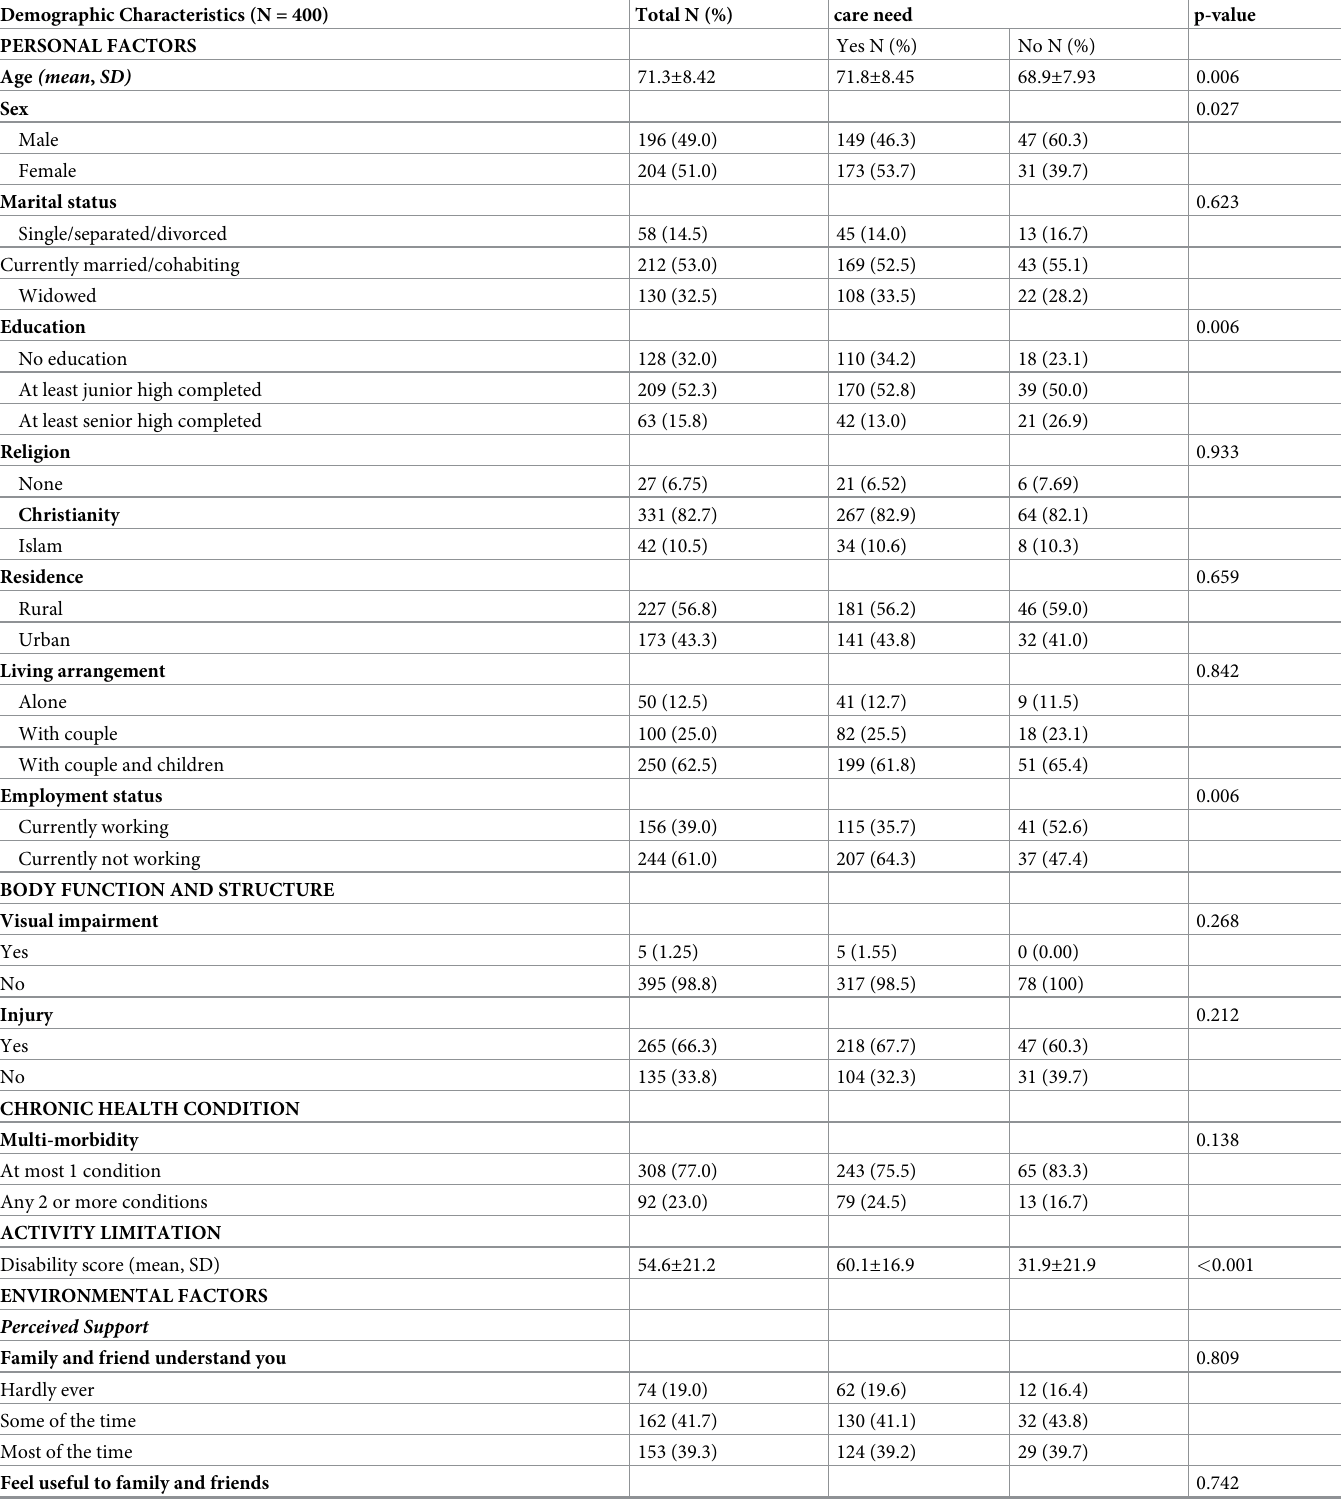
Table 2. Bivariate analysis of care needs across WHO-ICF